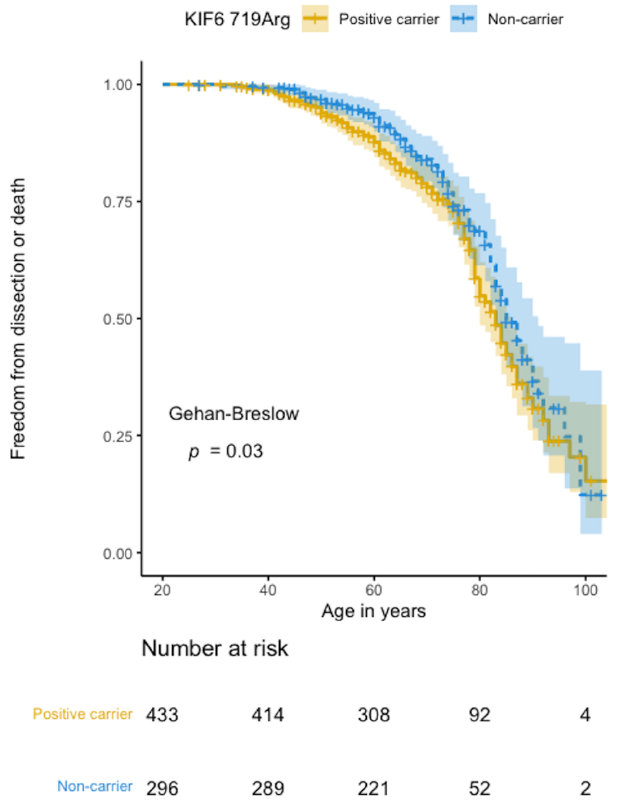
Figure A1. Freedom from dissection or death in the KIF6 719Arg carriers and non-carriers. Note the small but statistically significantly increased rate of events in the positive carriers.